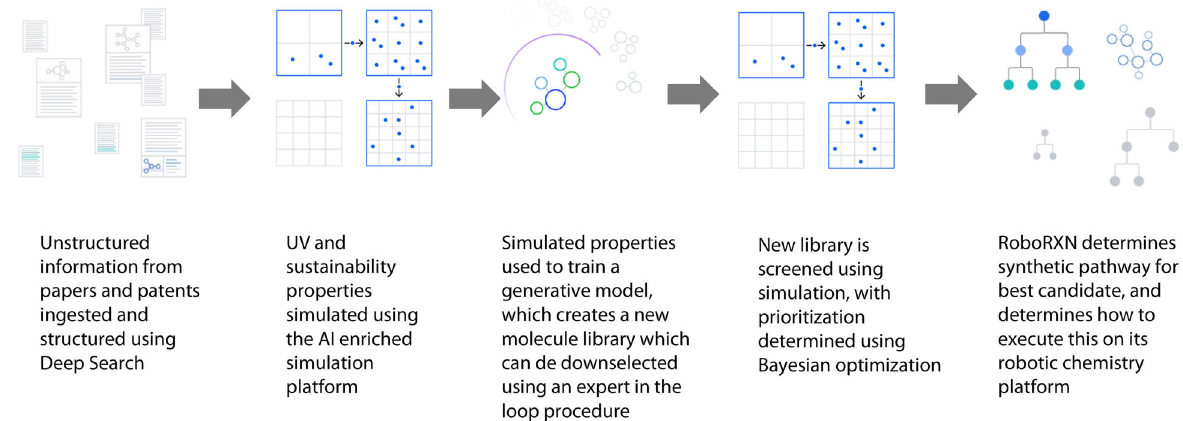
Fig. 7 Accelerating the discovery of novel photoacid generators. An example of how the technologies connect together to accelerate the discovery of novel